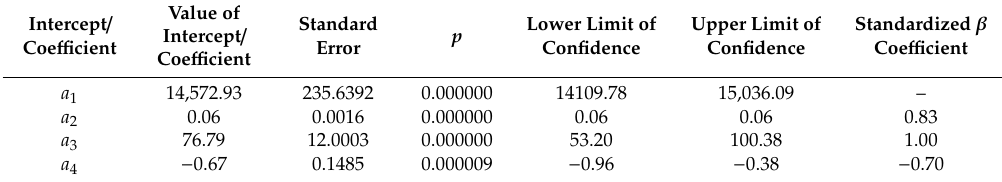
Figure 9. Visualization of 3D model of HHV of torrefied pruned biomass (model 2). Table 7. Statistical evaluation of HHV model of torrefied pruned biomass (model 2).